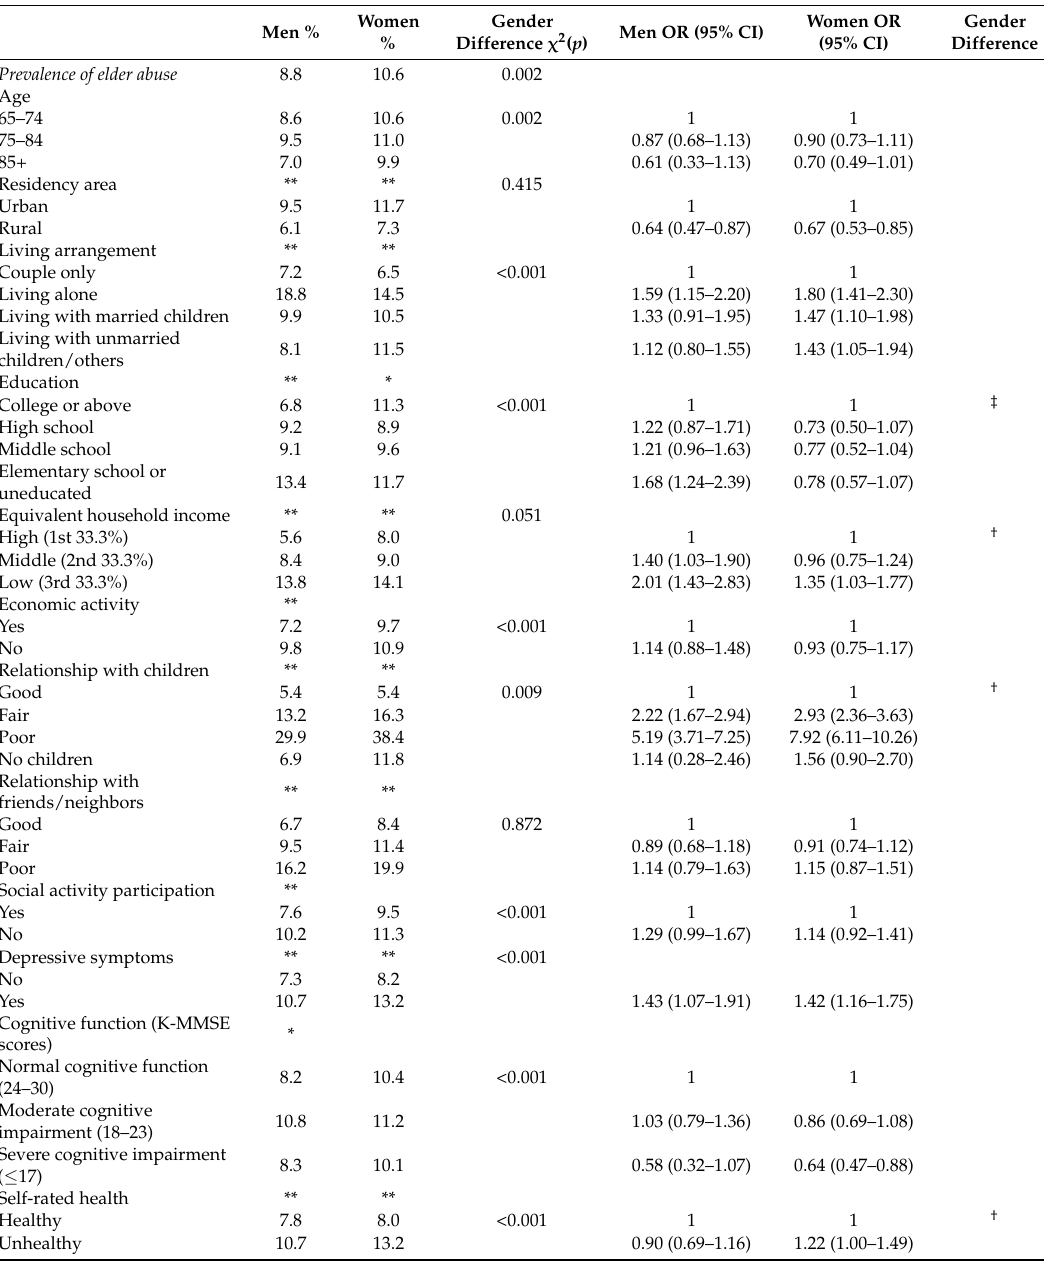
Table 4. Prevalence of elder abuse according to sociodemographic and health characteristics, and odds ratios (95% confidence intervals) for elder abuse among older men and